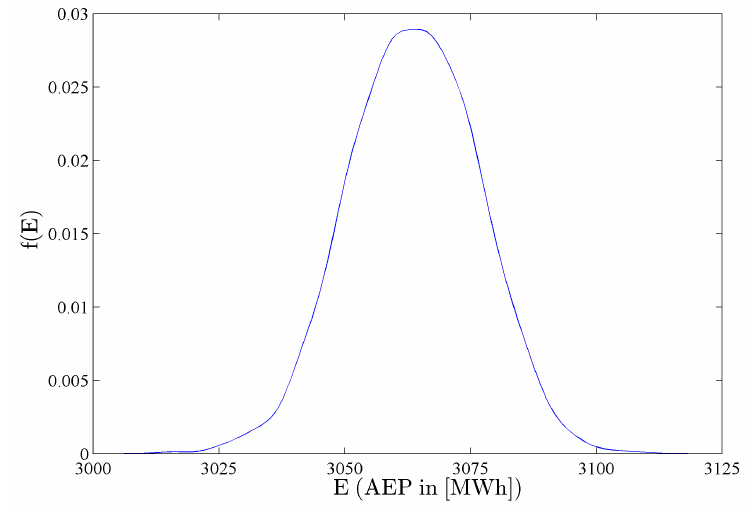
Figure 9. PDF of Weibull simulated AEP for the E44 wind turbine at